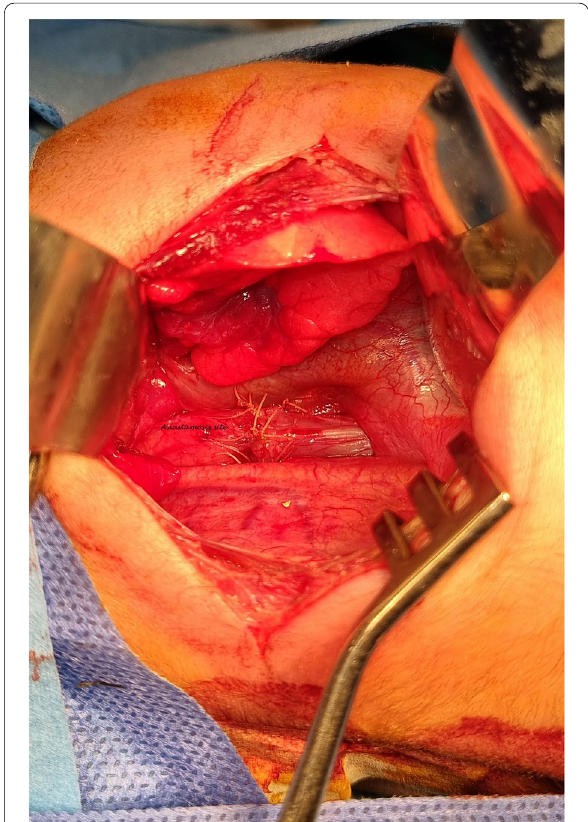
Fig. 7 Intra-op image showing primary anastomosis using Vicryl 5/0 sutures